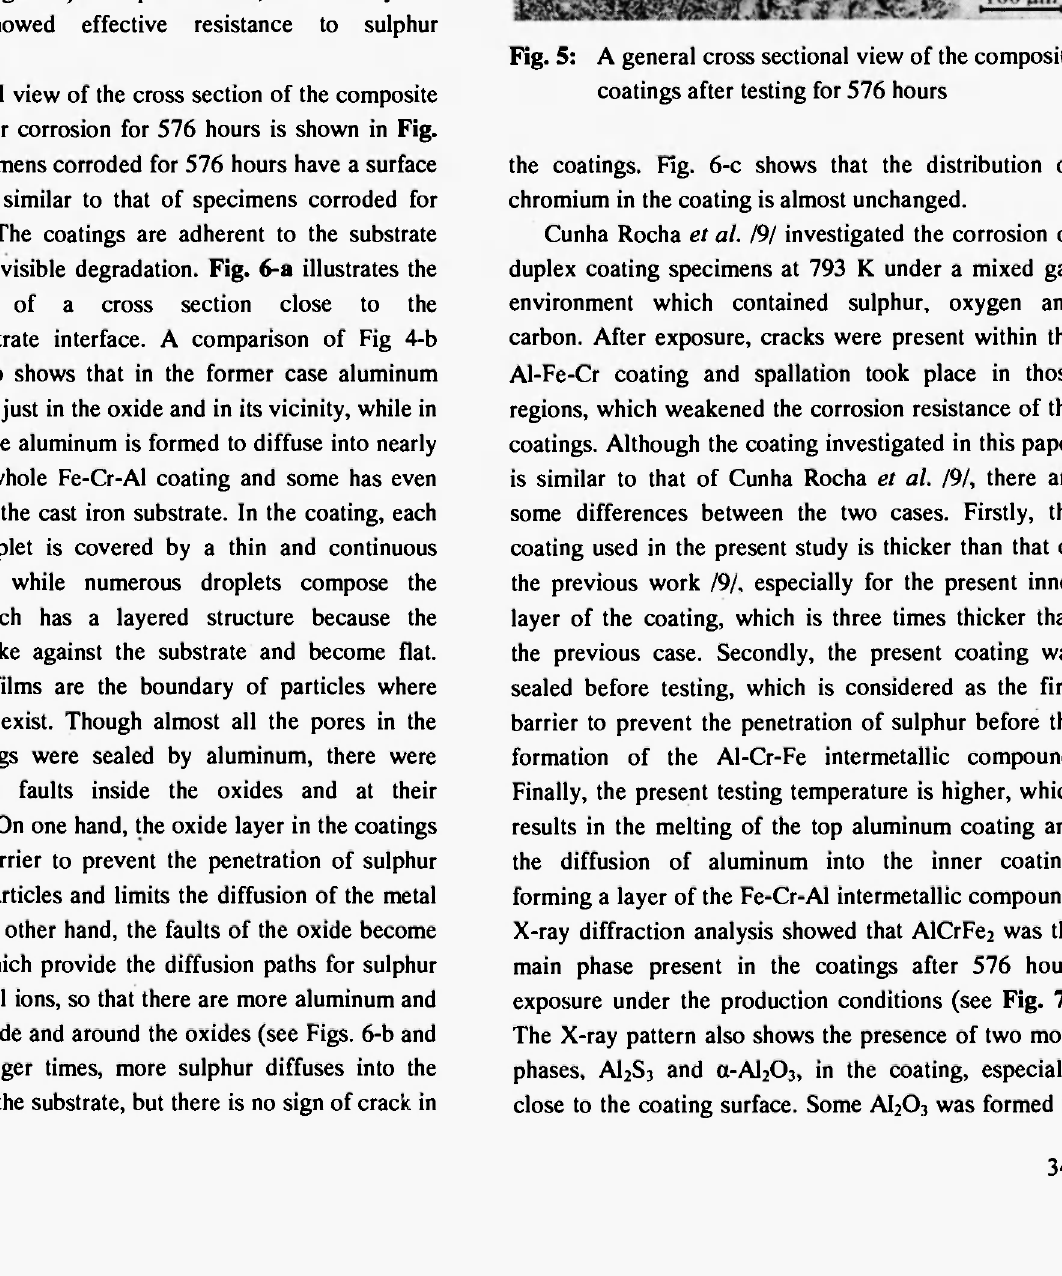
Fig. 5: A general cross sectional view of the composite coatings after testing for 576